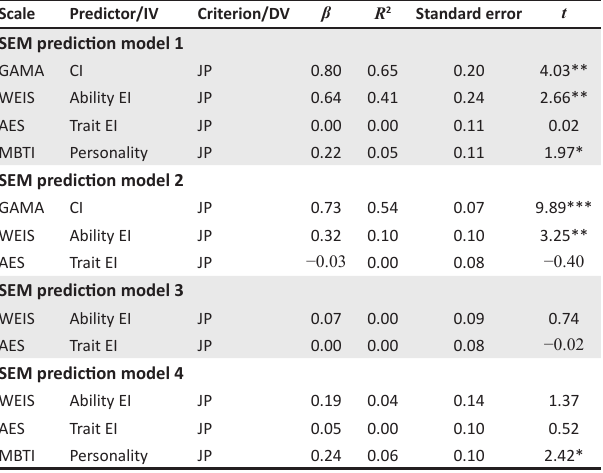
Ability emo(cid:31)onal inteligence Job